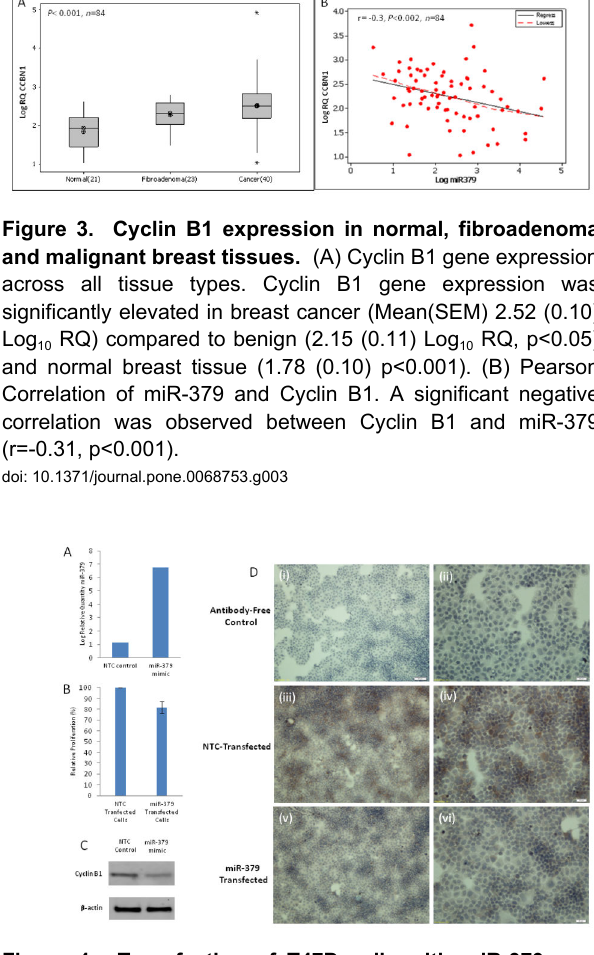
hours following transfection with miR-379 in T47D cells. An inhibition of cell proliferation was observed (7-24% inhibition, p<0.05 Figure 4(B)) in cells transfected with miR-379 compared to those transfected with NTC-mimic.